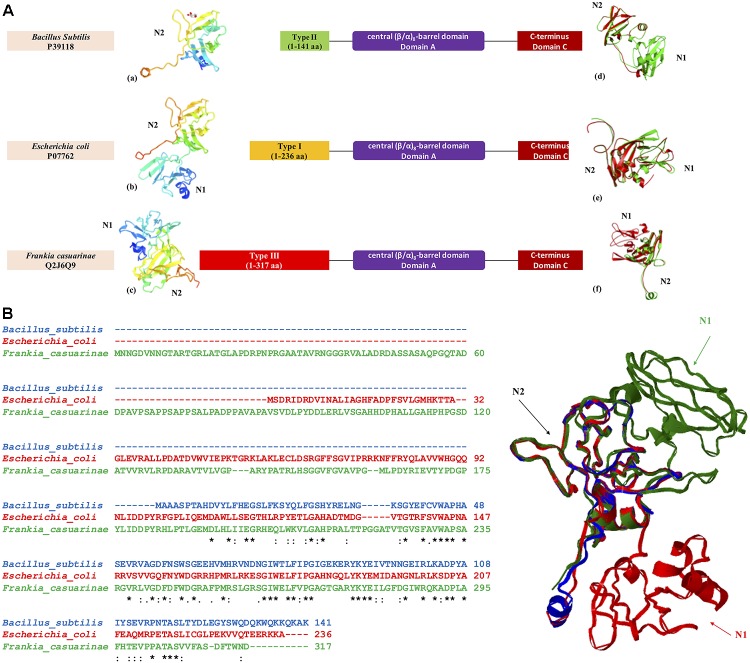
Three-dimensional structural model of GBE N-termini from three bacterial organisms Escherichia coli (P07762, Type 1 GBE), Bacillus subtilis (P39118, Type 2 GBE), and Frankia casuarinae (Q2J6Q9, Type 3 GBE). (A) N-terminal structures of GBEs (a. Bacillus subtilis, b. Escherichia coli, and c. Frankia casuarinae) and pair-wise superimpositions of GBE N-termini [d. Escherichia coli (green) and Bacillus subtilis (red), e. Escherichia coli (green) and Frankia casuarinae (red), and f. Bacillus subtilis (green) and Frankia casuarinae (red)]. (B) Multiple sequence alignments via Clustal Omega and superimposition of three bacterial GBE N-termini. Blue, red, and green ribbons represent 3D N-termini of B. subtilis, E. coli, and F. casuarinae, respectively. All N1 and N2 domains were specified with corresponding letters. N0 domain is failed to be constructed due to the lack of PDB template. Thus, it is not present. Star (∗), colon (:), and period (.) in multiple sequence alignment indicate identical, highly conservative, and semi-conservative, respectively.